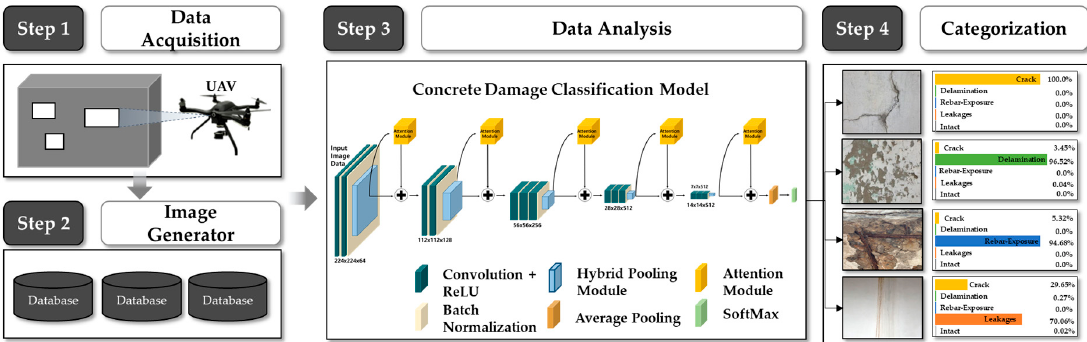
Figure 11. Conceptual diagram of concrete damage inspection